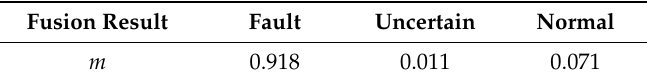
Table 7. The fusion